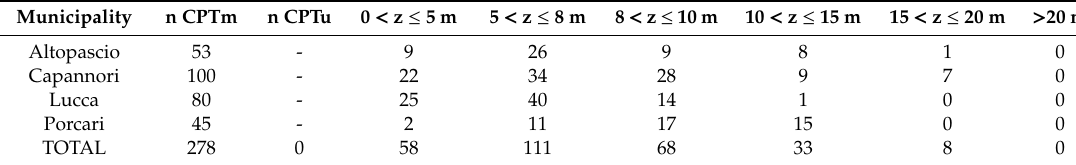
Table 3. CPT database for the macro-area of the Lucca